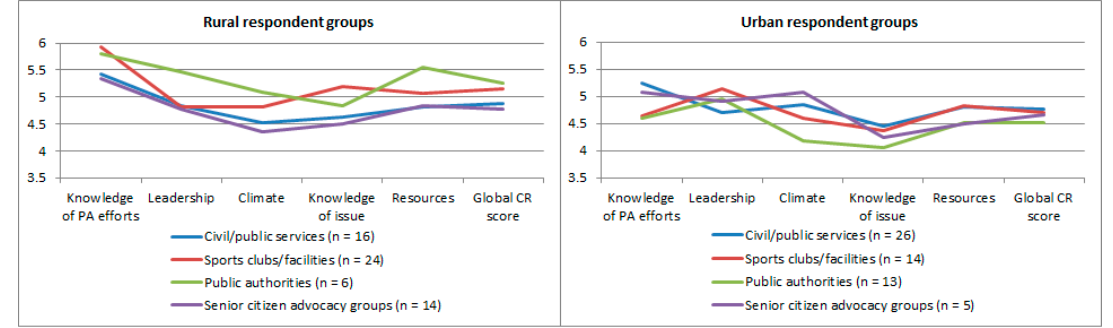
Figure 2. Community readiness scores per dimension and global score, stratified by rural and urban key respondents . PA: physical activity.